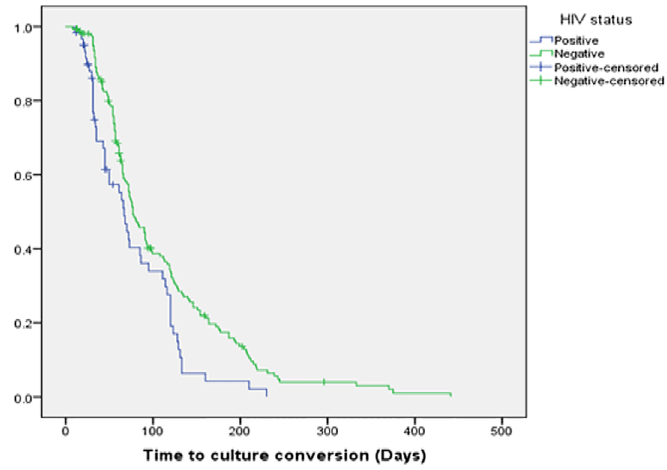
Fig 2. Kaplan-Meier survival plot of time to initial sputum culture conversion by HIV status.